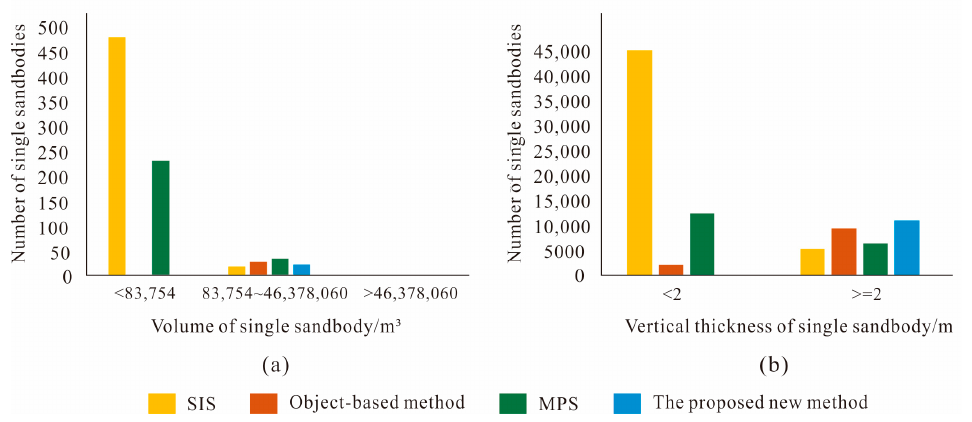
Figure 18. Comparison of simulation results corresponding to different methods. ( a ) Comparison diagram of bar sand volume; ( b ) comparison diagram of bar sand